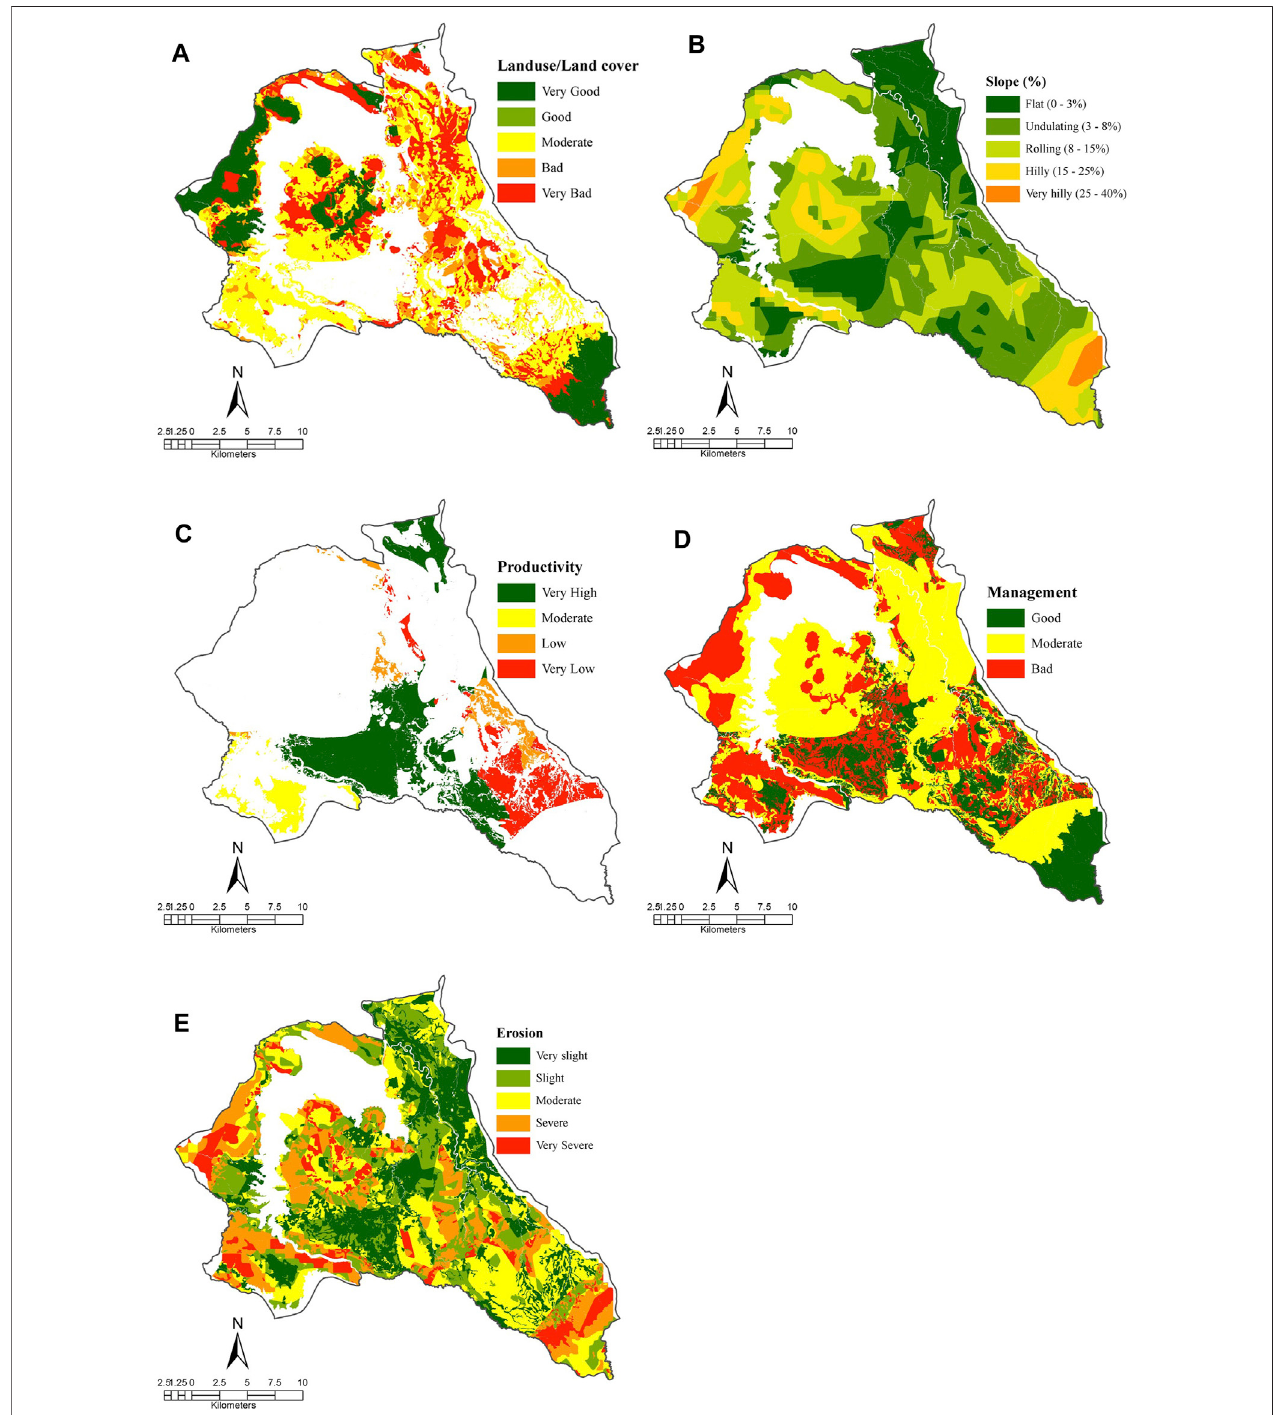
FIGURE 1 | Thematic maps for mapping